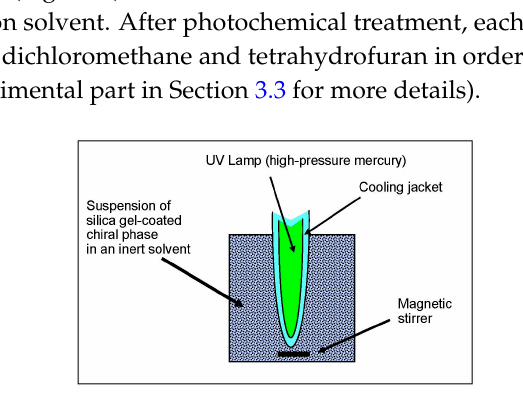
Figure 1. Schematic photochemical setup for immobilization of PMBC on silica gel.